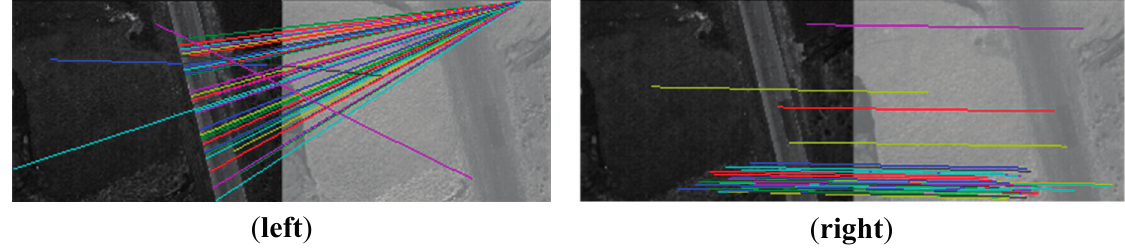
Figure 6. The band images with less artificial objects; ( a ) the infrared band; ( b ) the red band; ( c ) the green band; ( d ) the blue band.